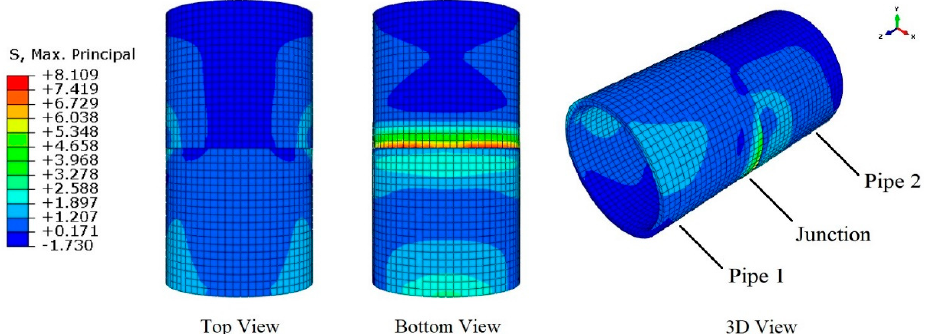
Figure 16. Stresses in the pipe wall under transient flow conditions (MPa).